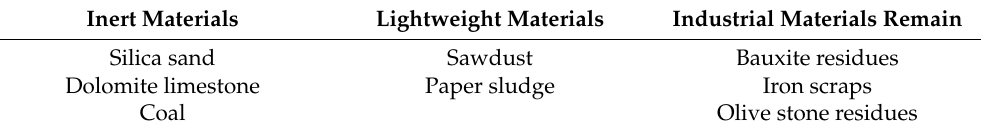
Table 1. The three (3) categories and the additives materials used for the current research.